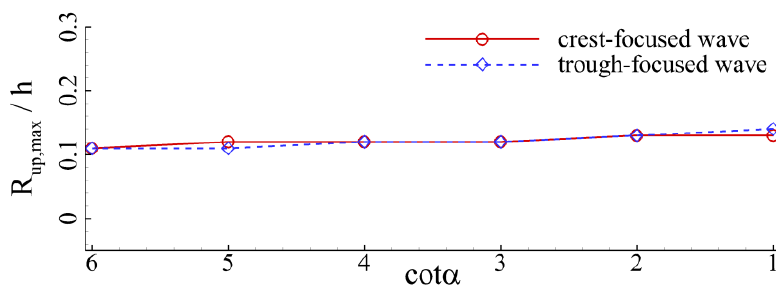
Figure 46. Wave energy dissipation rate versus the forereef slope.